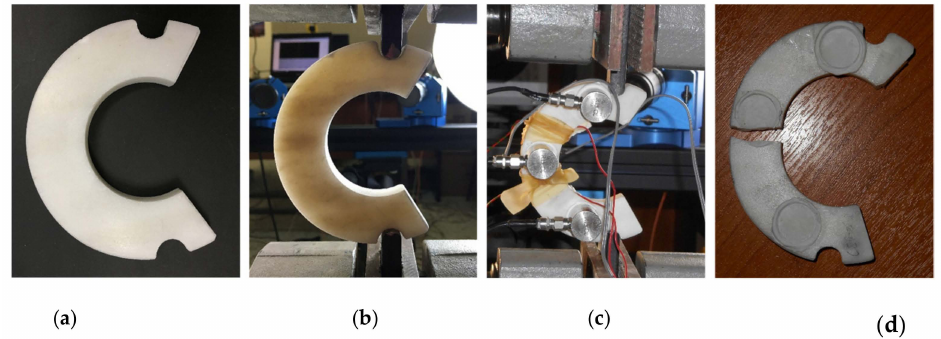
Figure 11. ( a ) A typical specimen; ( b ) the specimen while being prepared for testing; ( c ) the instru- mented specimen and the experimental set-up; ( d ) a fractured